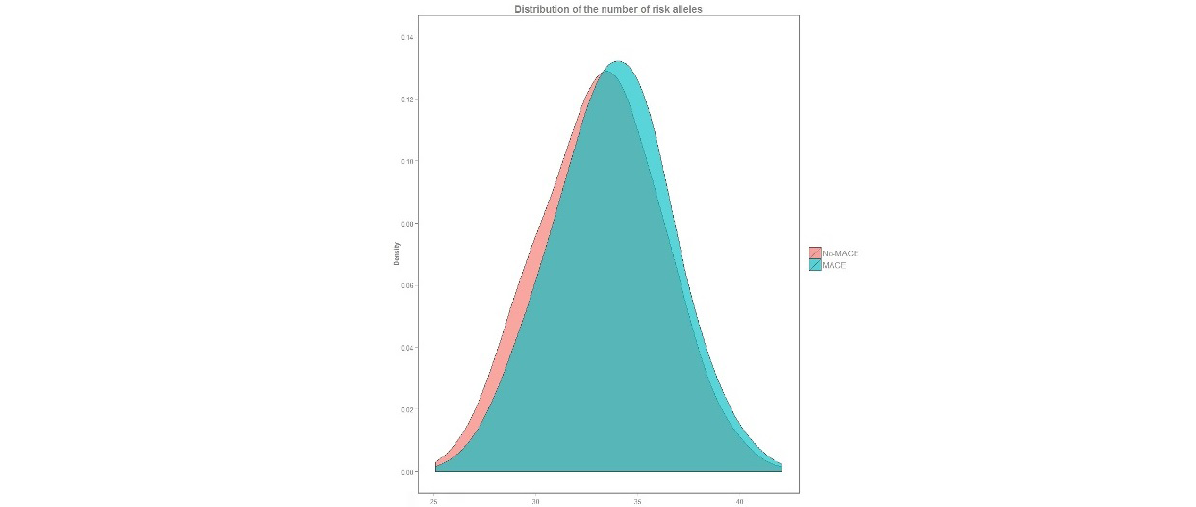
Figure 1 ‒ Distribution of the number of risk alleles in CAD patients with and without MACE.